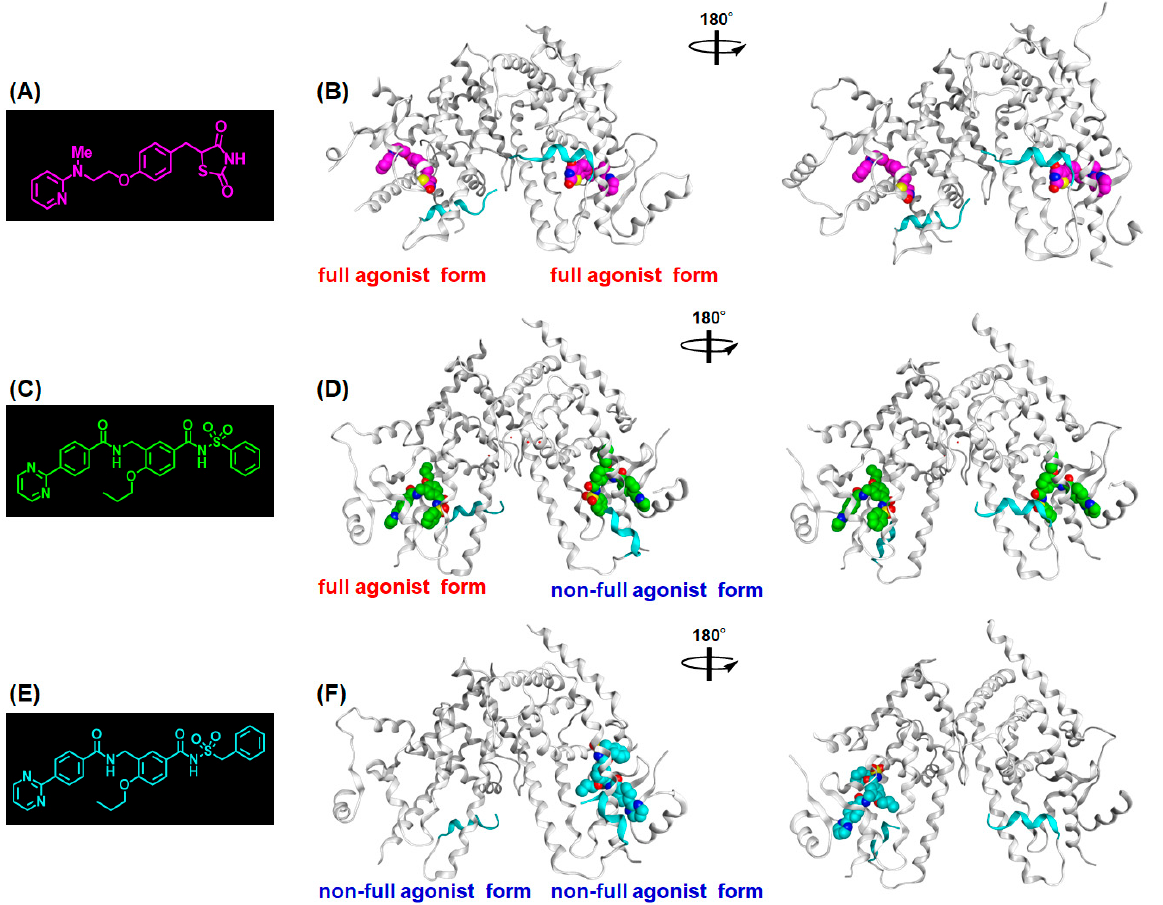
Figure 3. A comparison of the hPPAR γ ligands complexed with the hPPAR γ LBD. ( A ) Chemical structure of rosiglitazone. ( B ) Whole structure of the hPPAR γ LBD–rosiglitazone homodimer (PDB: 2PRG). Proteins are represented as a gray ribbon model and rosiglitazone is depicted as a magenta van der Waals model. ( C ) Chemical structure of MEKT-75. ( D ) Whole structure of the hPPAR γ LBD–MEKT-75 homodimer (PDB:3WMH). Proteins are represented as a gray ribbon model and MEKT-75 is depicted as a green van der Waals model. ( E ) Chemical structure of MEKT-76. ( F ) Whole structure of the hPPAR γ LBD–MEKT-76 homodimer (PDB:4YT1). Proteins are represented as a gray van der Waals surface model and MEKT-75 is depicted as a cyan van der Waals